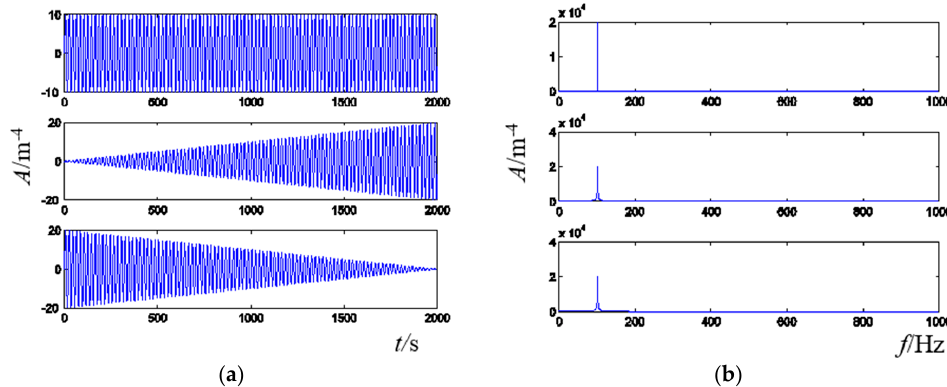
Figure 3. Illustration of the relationship between time-domain signals and frequency-domain signals. ( a ) Time-domain signal; ( b ) Frequency-domain signal.